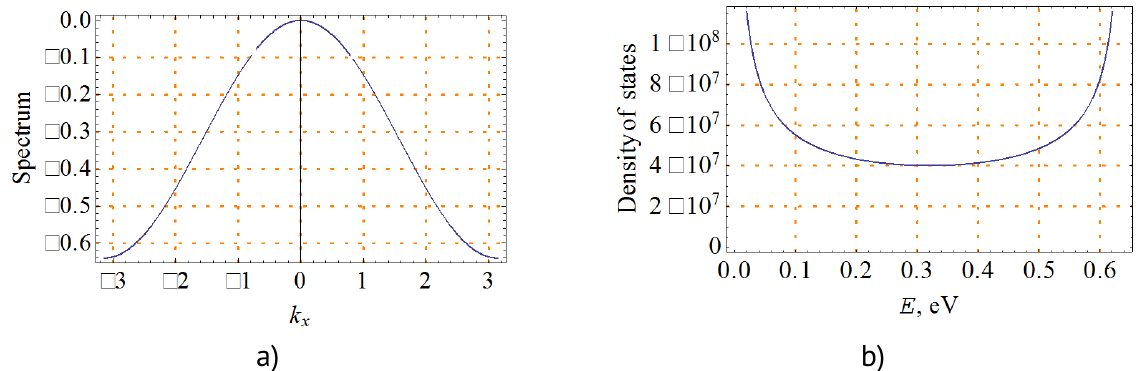
Figure 1. Energetic spectrum (a), and density of electronic states (b) for T = 300 K.